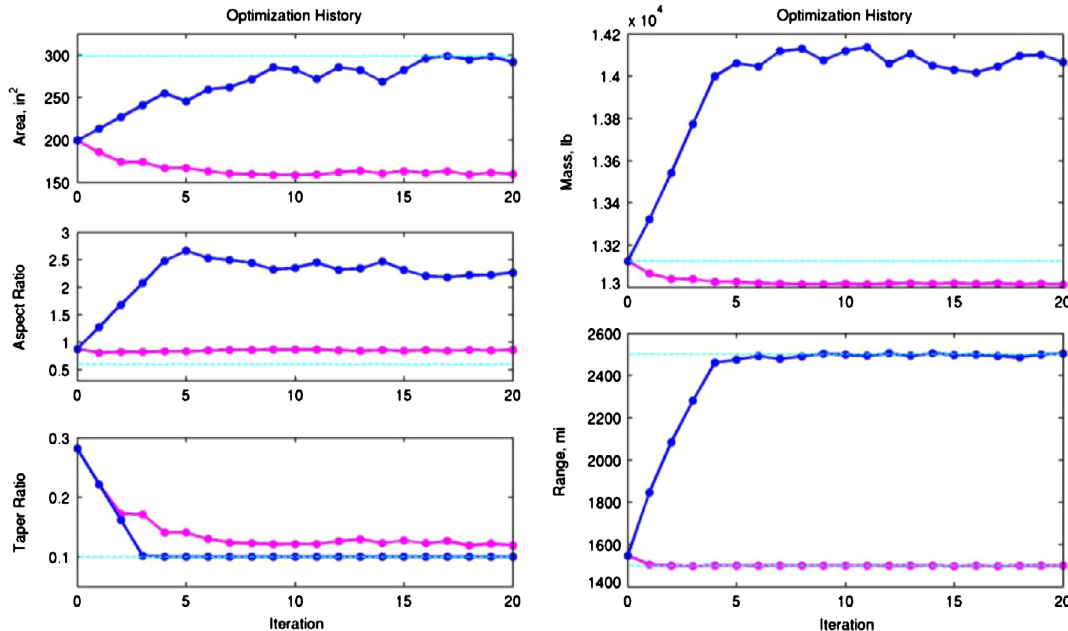
Figure 7. Results from ESAVoptimization illustrate how the design variables, objective and constraint functions are manipulated by the SLP technique (1500 mi range constraint, magenta; 2500 mi range constraint, blue).